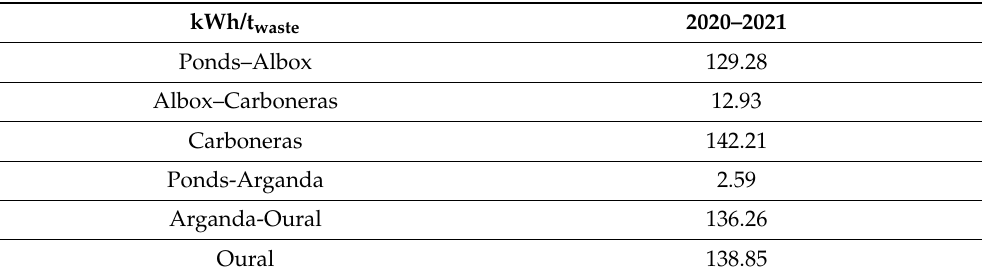
Table 5. Transport